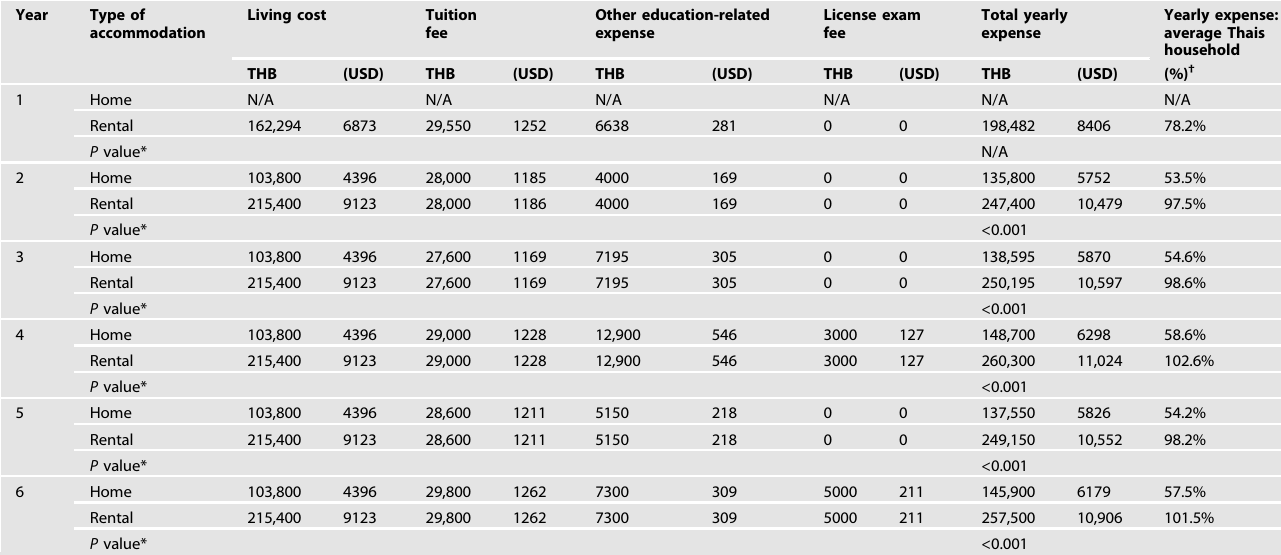
Table 3. Yearly expense of dental student ( N =